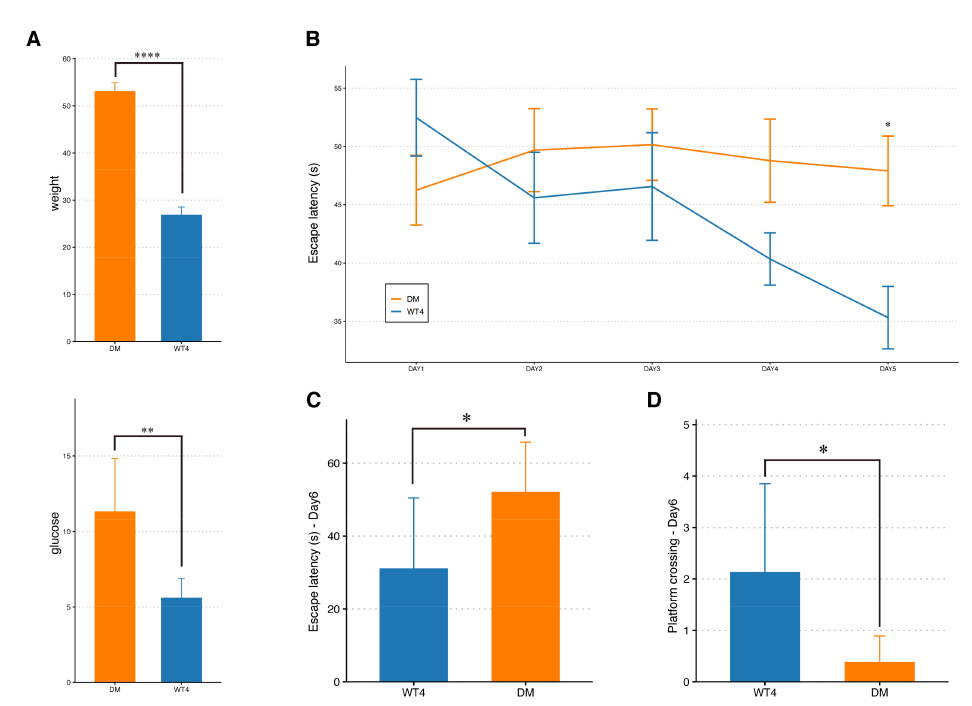
Figure 1. Body weight and blood glucose measurement and cognitive function assessment. ( A ) The body weight and blood glucose of 4-month-old db/db mice were significantly higher than those of wild-type (wt) mice ( t -test; ** 0.001 < p < 0.01, **** p < 0.0001). ( B ) Line chart of average escape latency (Two-way ANOVA; * 0.01 < p < 0.05). ( C , D ) On day six, the average escape latency of db/db mice was significantly prolonged, while the number of platform crossing was significantly reduced ( t -test; * 0.01 < p <